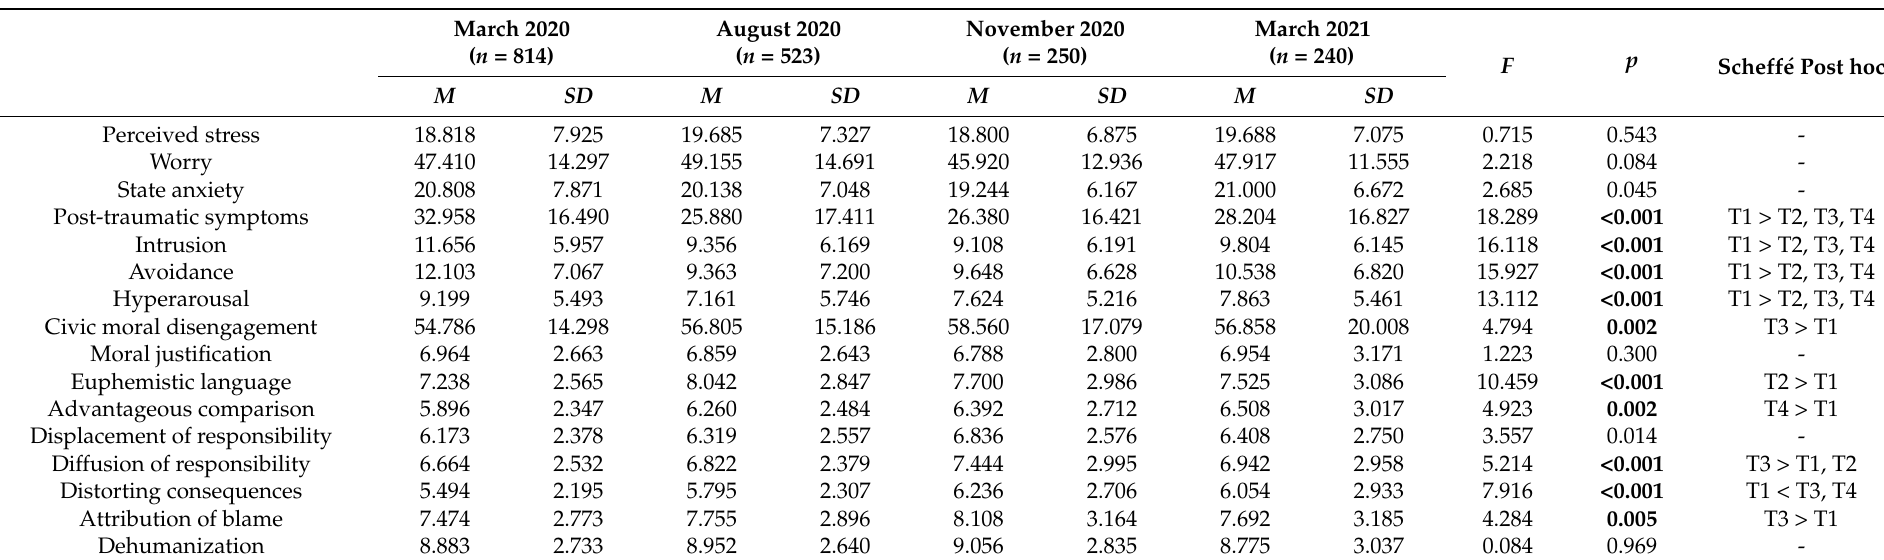
Table 3. Means, standard deviation, and comparisons of perceived stress, post-traumatic symptoms, state anxiety, worry, and civic moral disengagement between COVID-19